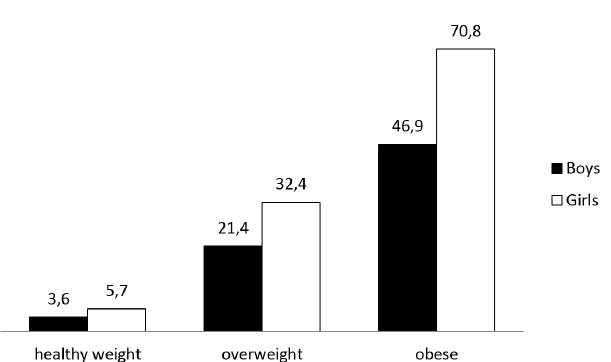
Figure 1. Prevalence of metabolic syndrome by sex and body mass index in children aged 6-10 years